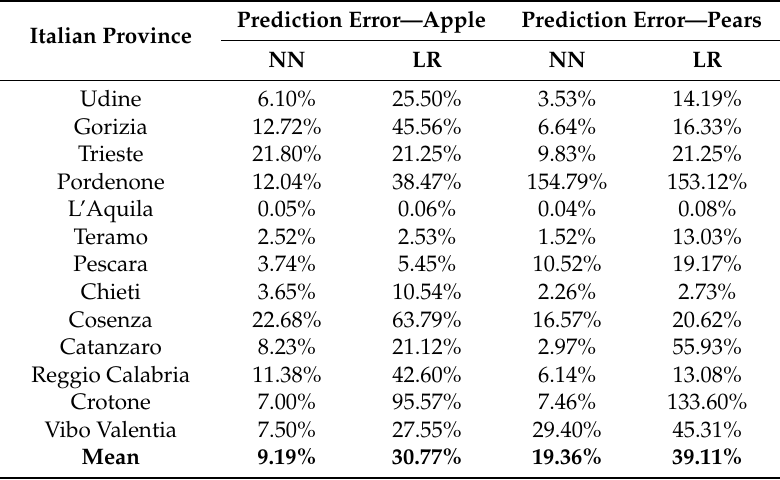
Table 4. Task 1: apples and pears crop prediction error exploiting the neural network and the polynomial linear predictive model on the Istat dataset.